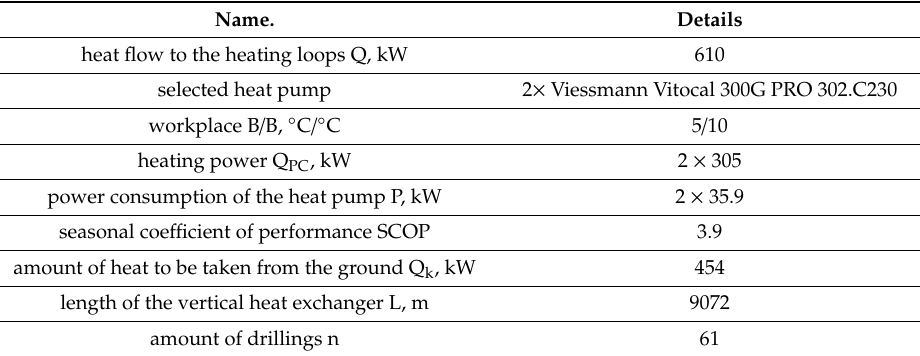
Table 2. Summary of calculation data for the analyzed heat pump solution.